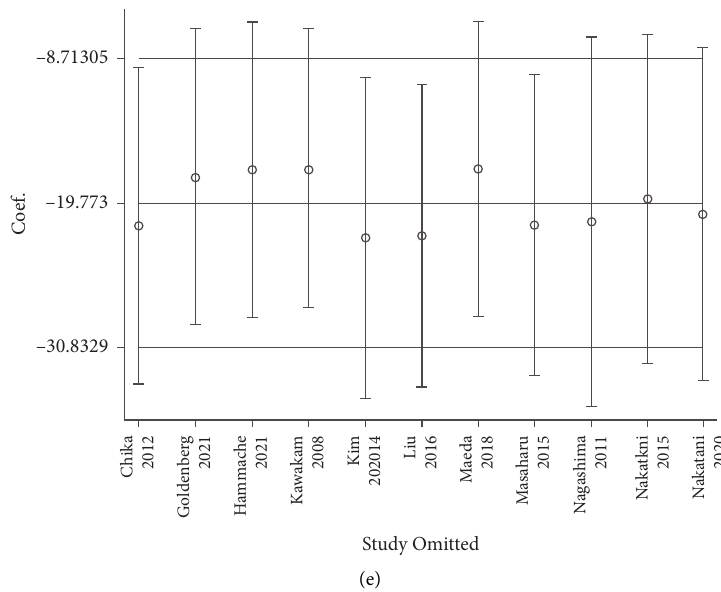
Figure 3: Sensitivity analysis plot of EFT volume differences among different populations: (a) healthy participants and all AF cases; (b) healthy participants and paroxysmal atrial fibrillation; (c) healthy participants and persistent atrial fibrillation; (d) paroxysmal atrial fibrillation and persistent atrial fibrillation; and (e) recurrent and nonrecurring patients after